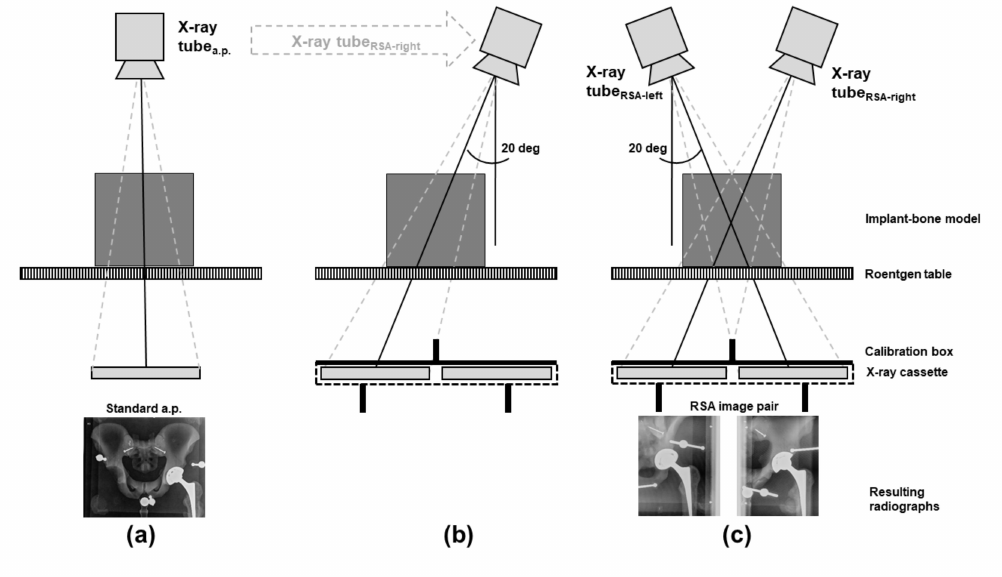
Figure 1. Radiological setup. ( a ) Classical set up to generate an a.p. radiograph of the pelvis. The implant-bone model is located in the middle of the central X-ray beam. ( b ) When X-ray tube a.p. shifts to the X-ray tube RSA-right position, the classical radiological setup is converted to ( c ) a uniplanar RSA setup. Both roentgen tubes are arranged at an angle of 20 deg to the vertical above the calibration box. The implant-bone model is located at the intersection of both X-ray beams.